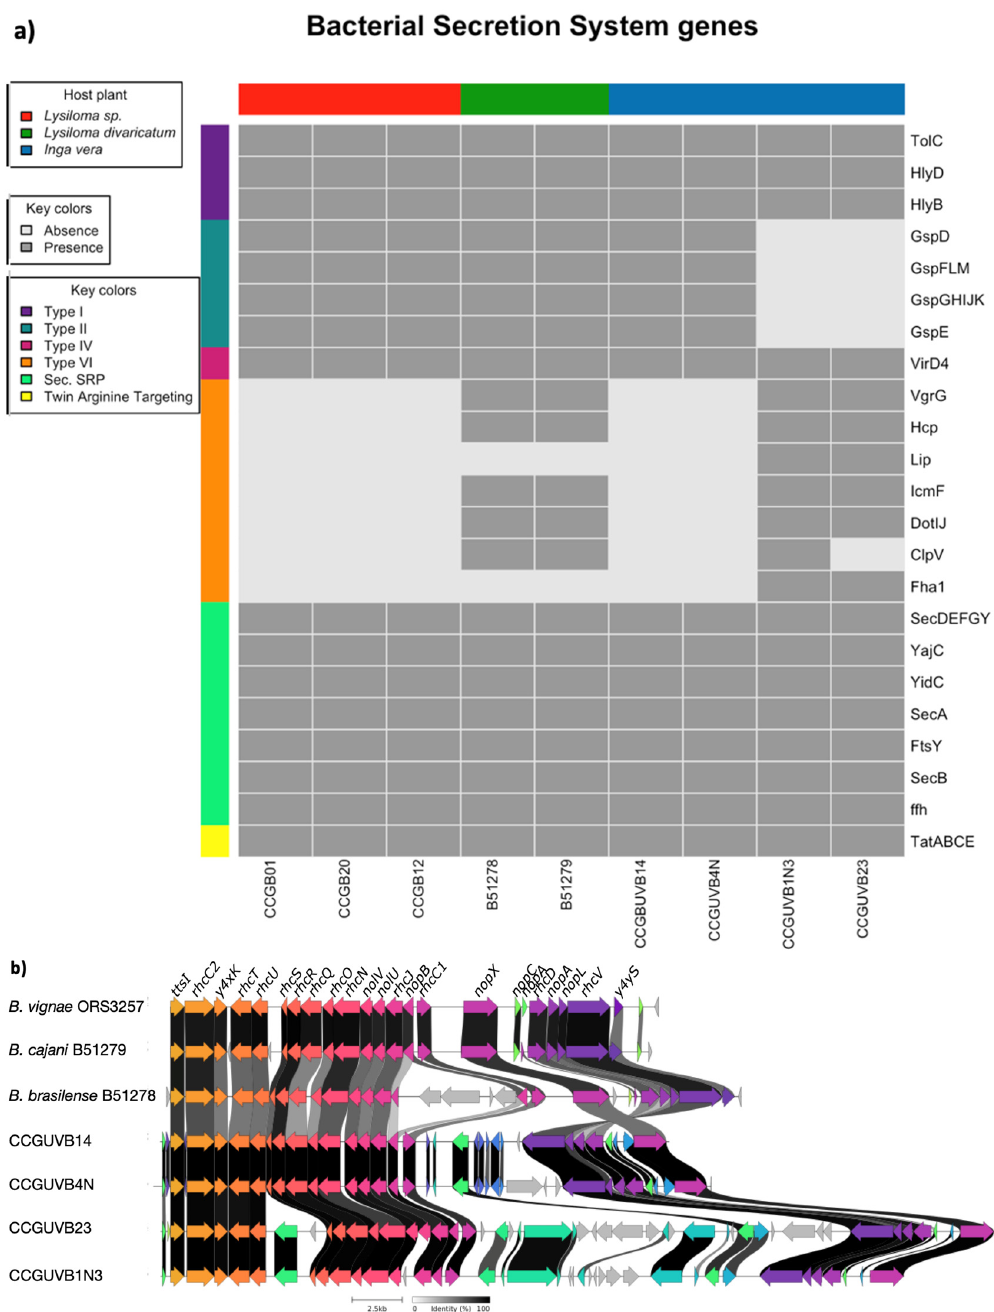
Figure 7. Comparative analysis of Secretion System genes present in Lysiloma spp. and Inga vera Bradyrhizobium isolates. ( a ) Presence/absence table of coding genes for different types of secretion system, predicted with GhostKOALA. The top sidebar indicates the legume host: red for Lysiloma sp., green for L. divaricatum and blue for I. vera . The left sidebar indicates the Secretion System Type. ( b ) Alignment of the coding region for the T3SS apparatus of B. vignae against the isolates of L. divaricatum and I. vera , made with Clinker. The connecting lines indicate the identity percentage of each gene according to the intensity bar below the figure. Only >35% of identity homologies are displayed.